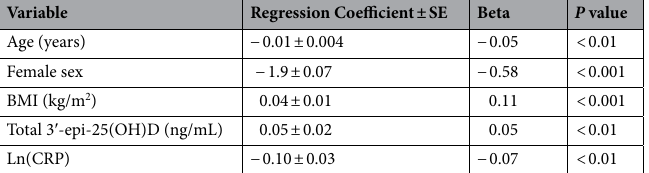
Table 6. The association between total 3 ′ -epi-25(OH)D and haemoglobin levels was independent of hsCRP. After controlling for hsCRP, total 3 ′ -epi-25(OH)D remained significantly associated with haemoglobin levels, independently of other factors.